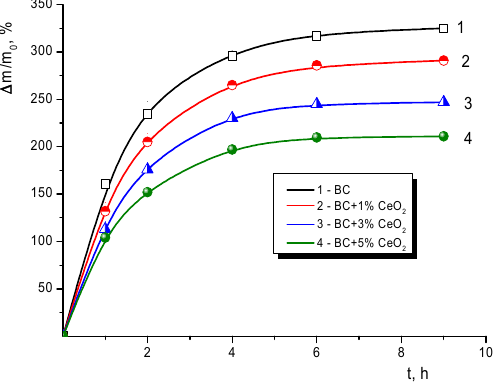
Figure 5. Swelling kinetics of bare BC and BC-CeO 2 nanocomposite films.